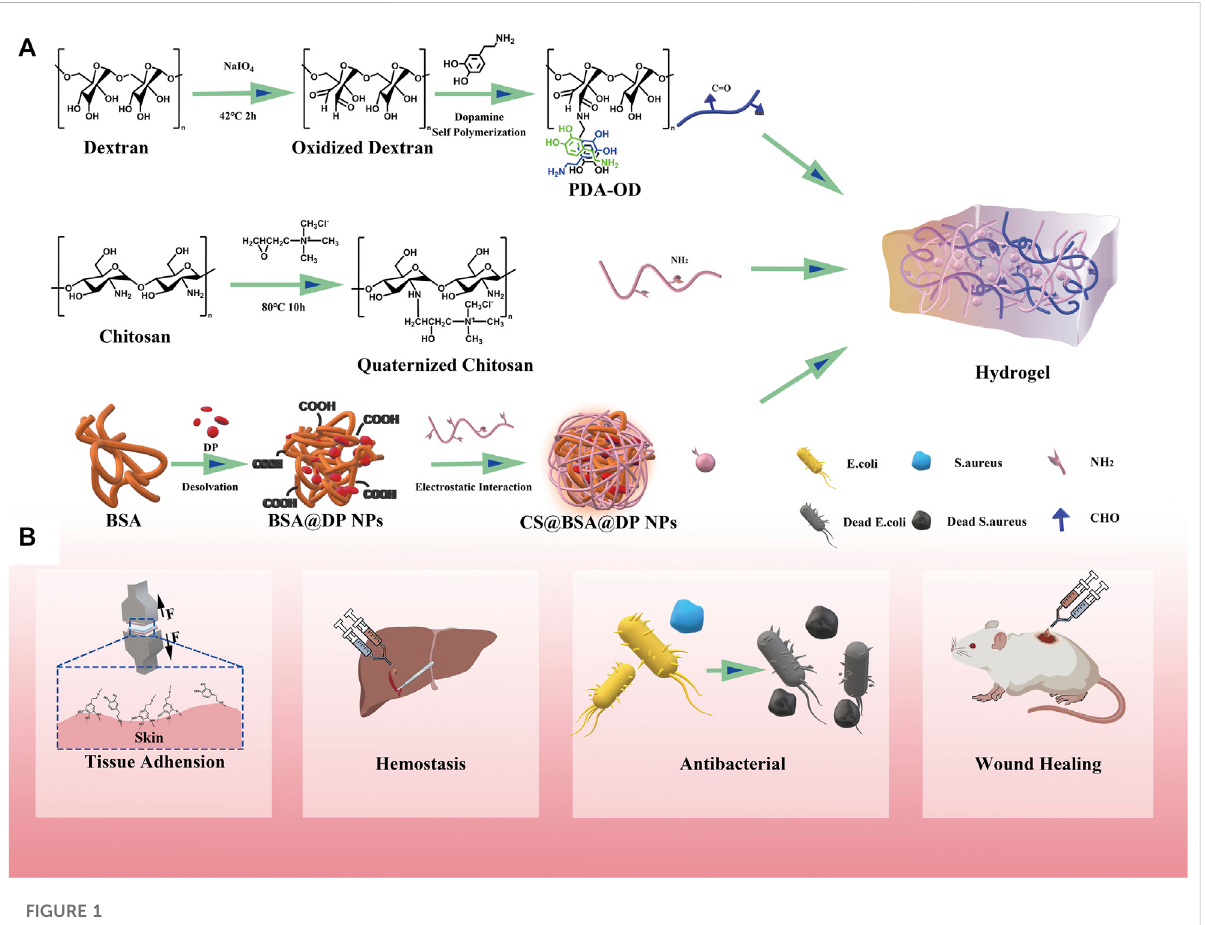
FIGURE 1 Illustration of a multifunctional all-in-one adhesive hydrogel for treating perianal infectious wounds. (A) Synthesis scheme of QPDN@DP hydrogel. (B) Schematic illustration of the main functions of the